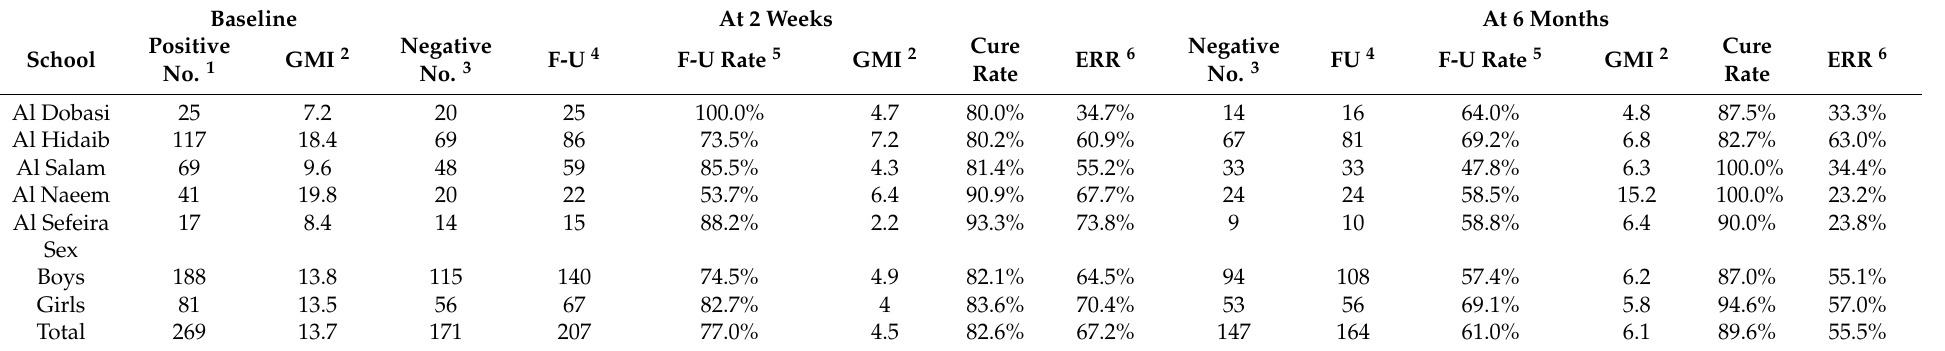
Table 4. Cure rate and egg reduction rate at 2 weeks and at 6 months after mass drug administration.